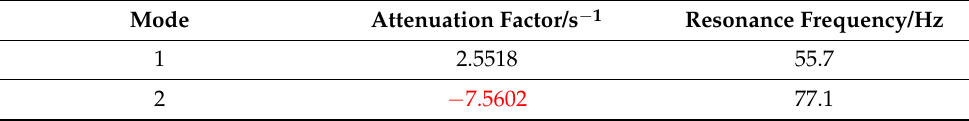
Table 2. The resonance modes below 100 Hz in the Wind Power Base.